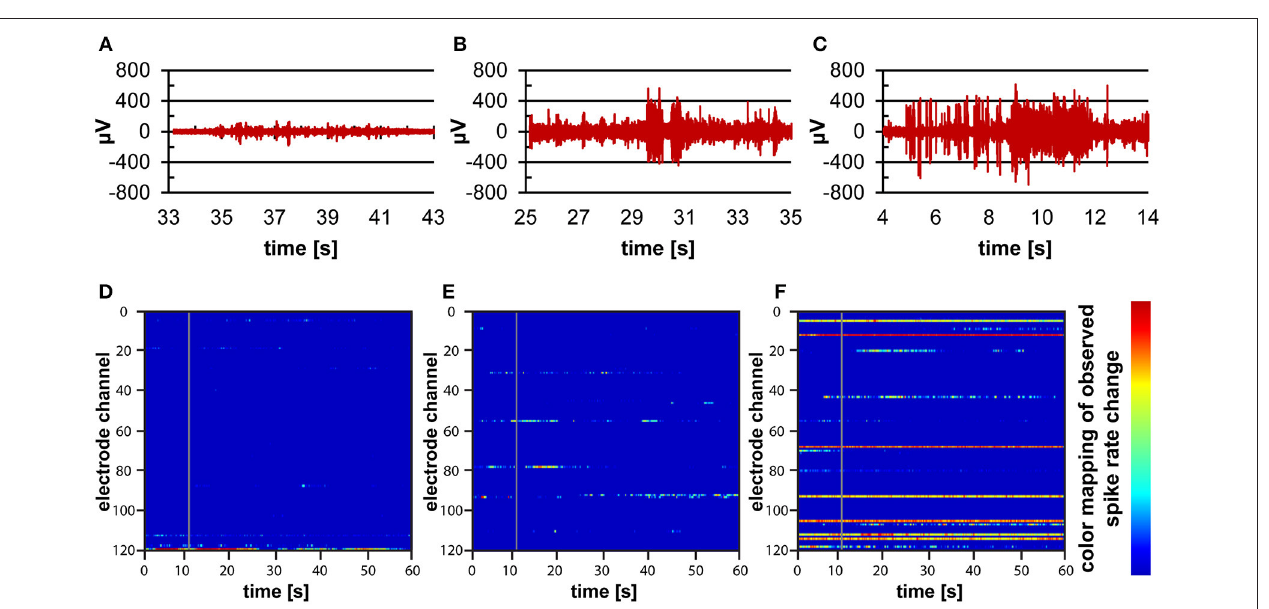
FIGURE 6 | Electrophysiological measurements on human iPSC-derived cortical neurons within a microbioreactor on a MEA. (A–C) Filtered data recordings of spontaneous activity of one electrode for 10s at 7 DIV (A) , 14 DIV (B) , and 21 DIV (C) of the 3D cell culture, showing the increase in spontaneous activity of cells. (D–F) Raster plots showing 60s of spontaneous activity for all electrodes of the MEA at 7 DIV (D) , 14 DIV (E) , and 21 DIV (F) of the 3D neuronal cell culture. The color bar to the right displays the color associated with high (red) to low (blue) spiking activity rates, showing that over time more electrodes pick up more spontaneous activity from the